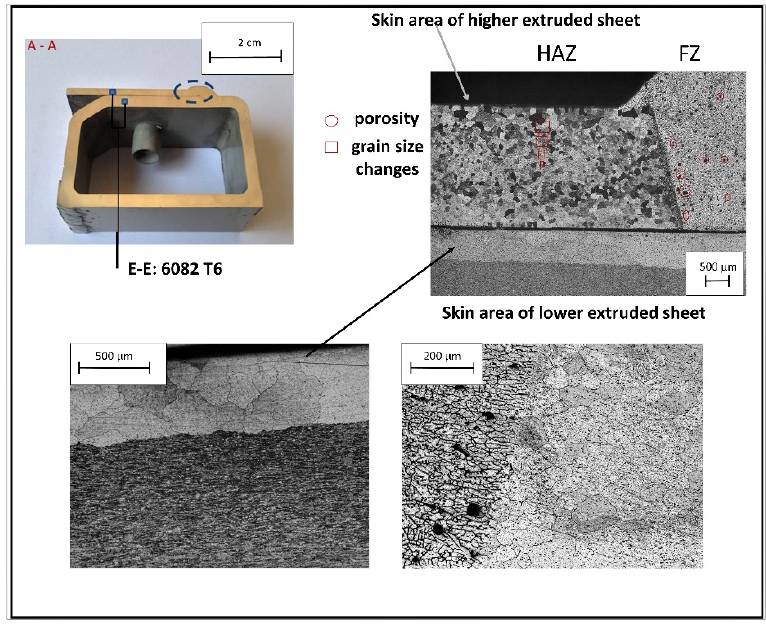
Figure 3. Defects and microstructures of metal inert gas (MIG) frame joints. E-E combination.